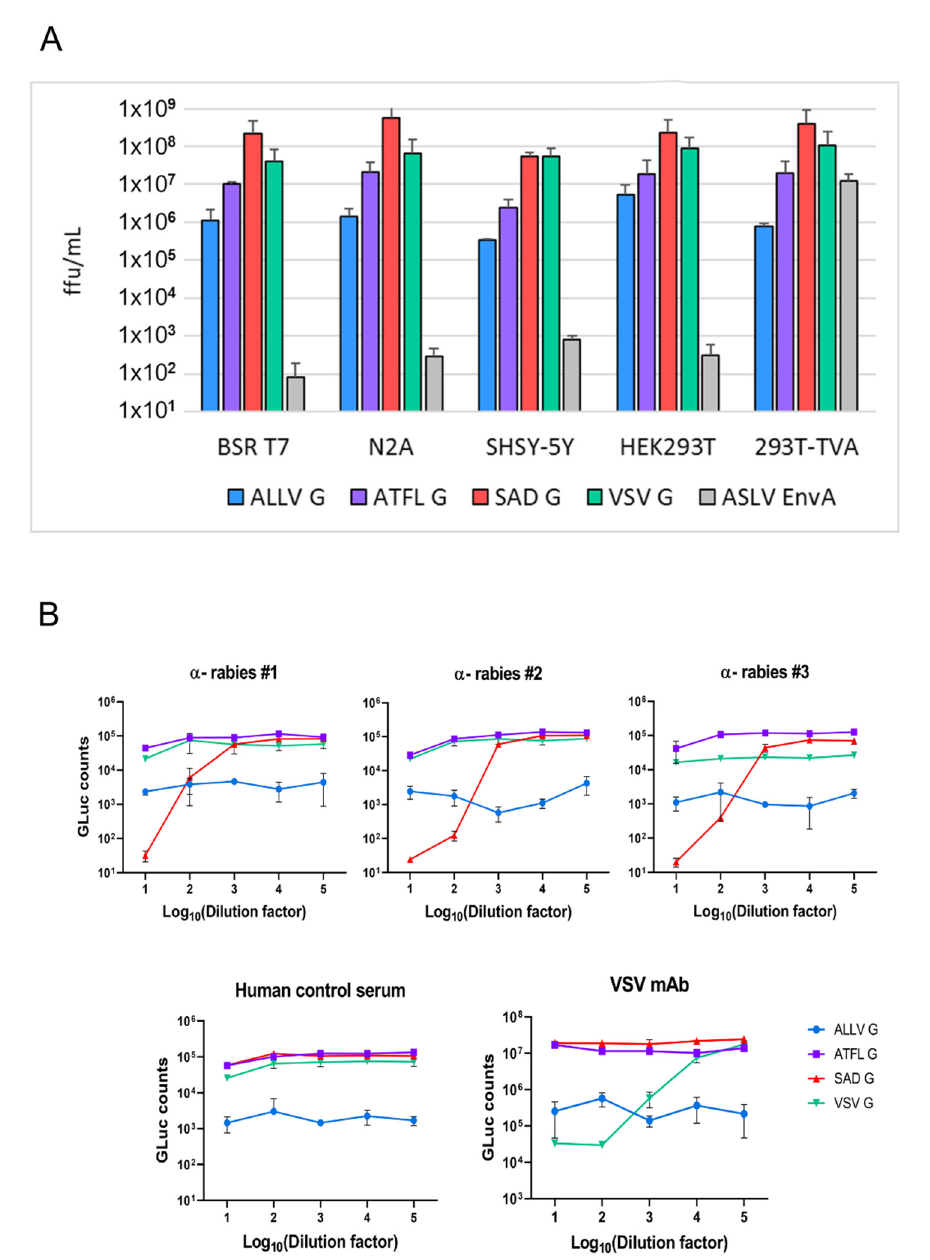
Figure 3. Infectivity of RABV pp for human and rodent cell lines. ( A ) Infectious titers of RABV particles pseudotyped with the indicated G proteins on human and rodent cells, including neuronal (mouse N2A, human SHSY-5Y), and kidney cell lines (human HEK293T, hamster BSR T7/5). The image integrates results from two independent experiments with SAD ∆ G-eGFP and SAD ∆ G-GLuc-mNeongreen replicons and two replicates each. Titers were determined by manually counting eGFP-expressing cells, and the mean of the two distinct replicons and standard deviation are depicted. Titers of the control EnvA pp (input control) were determined in triplicate with SAD ∆ G-GLuc-mNeongreen replicons. ( B ) Specific neutralization of RABV SADG pp by human rabies immune sera and of VSV G pp by a VSV-specific mAb. RABV pp were incubated with serial dilutions of the indicated sera or mAb, and Gaussia -Luciferase activity was determined in infected BSR T7/5 cells 3 d.p.i. Both ATFLV G and ALLV G could effectively mediate the infection of RABV pp in all tested rodent and human cell cultures, illustrating the functional replacement of the